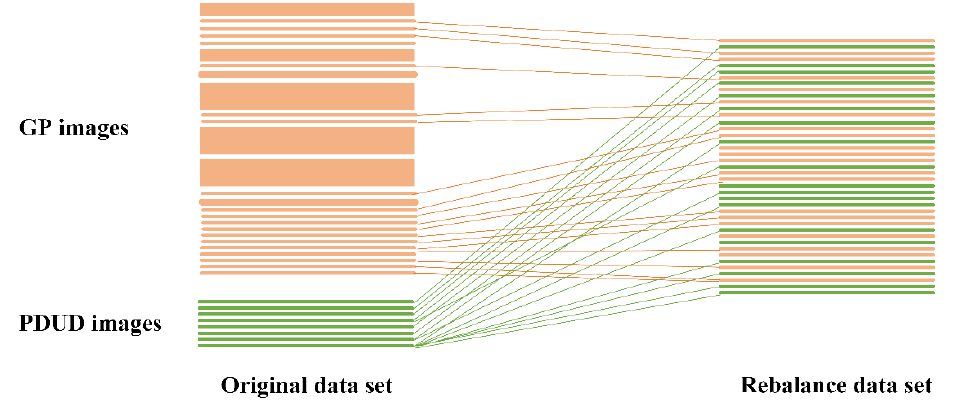
Figure B5. Resampling technique to rebalance the two-class distributions of images.